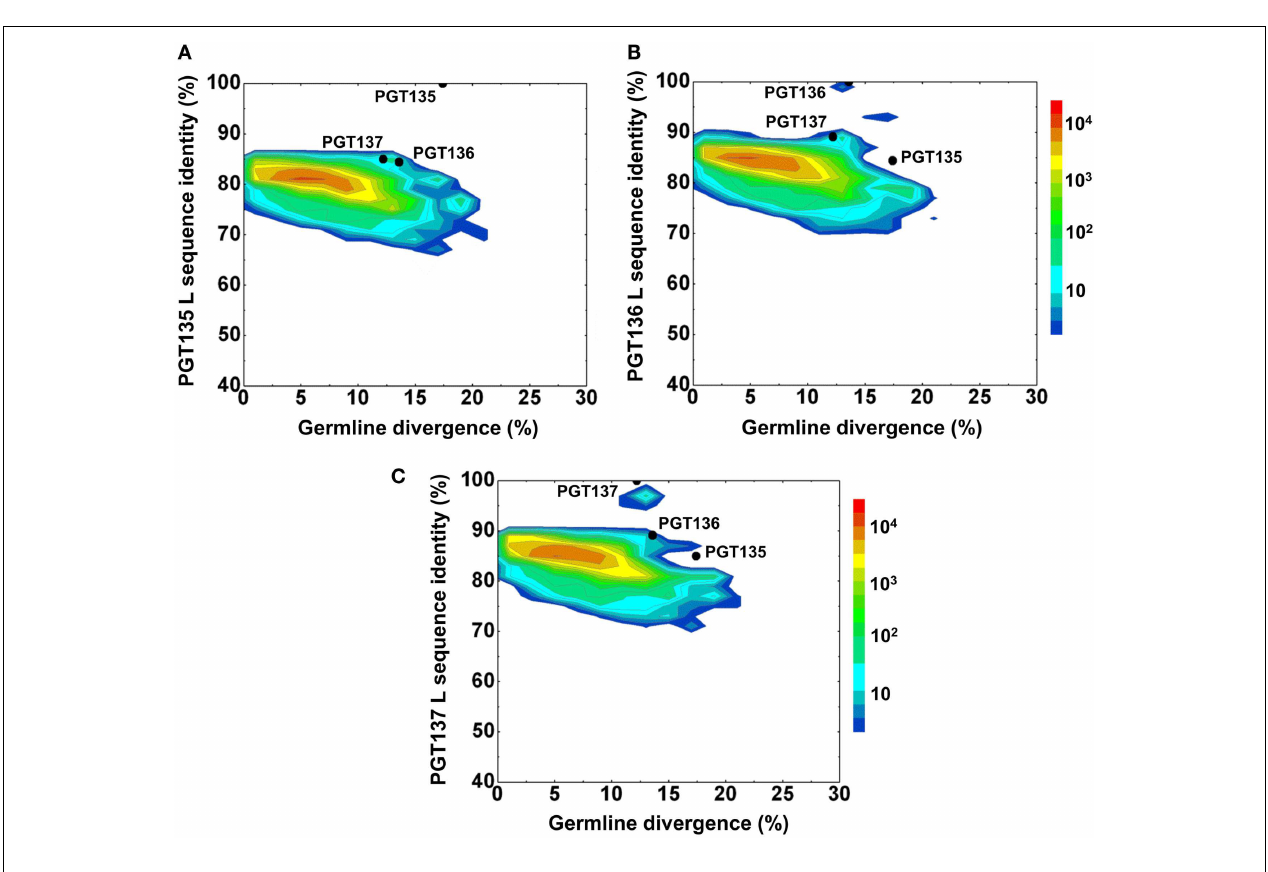
plotted as a function of sequence identity to the light-chain variable-domain of PGT135 (A) , PGT136 (B) , and PGT137 (C) and of sequence divergence from inferred IGKV3-15 germline allele. Color coding indicates the number of